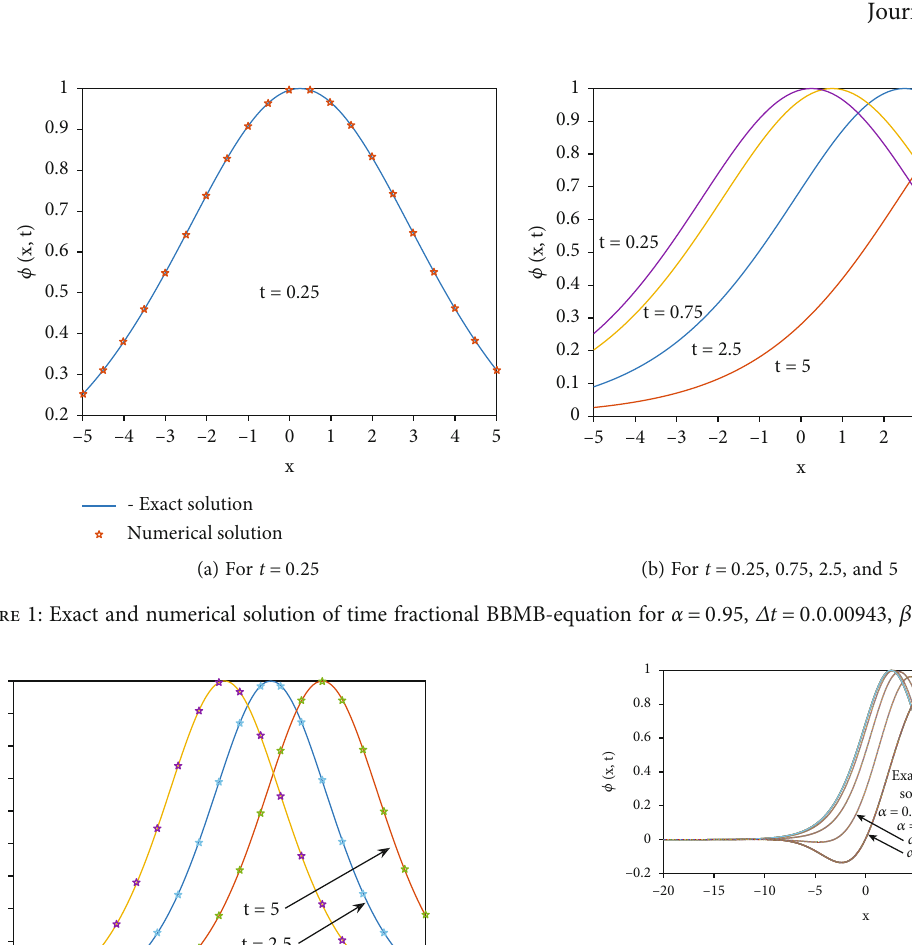
Figure 3: E ff ect of αε ð 0, 1 Þ of time fractional BBMB-equation for x ε ½ − 10, 10 (cid:2) , Δ t = 0 : 011 , β = 1 , and h = 0 : 01